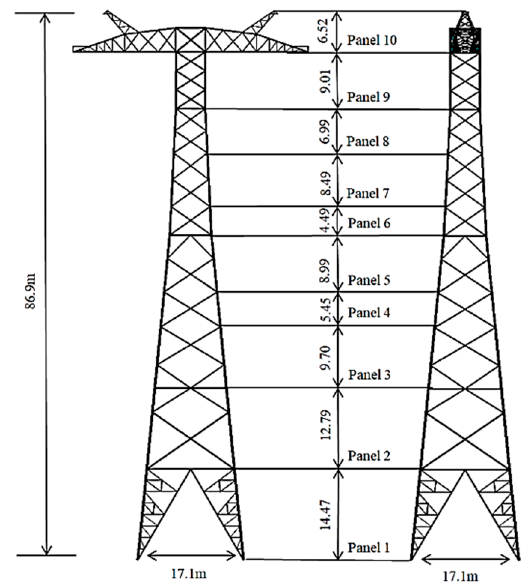
Figure 1. Details of transmission tower.